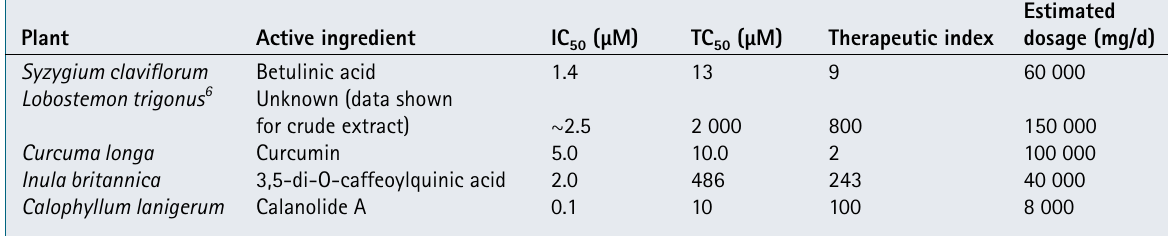
TABLE III. ANTIRETROVIRAL ACTIVITY AND ESTIMATED DOSAGE OF SEVERAL NATURAL PRODUCTS*